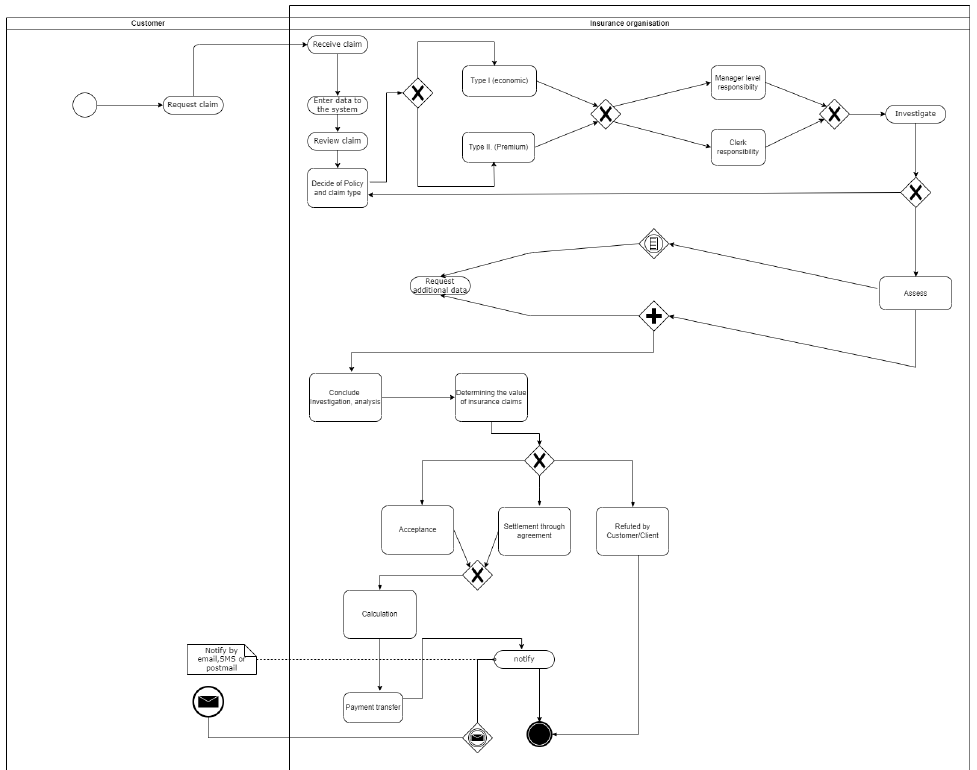
Figure 1. Insurance claim/Activity